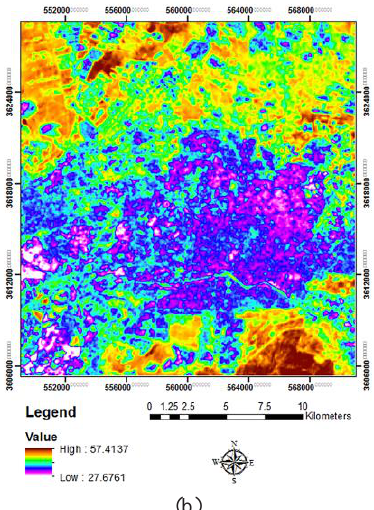
Figure 3 . Land surface temperature layers for (a) 1998 and (b) 2014 node